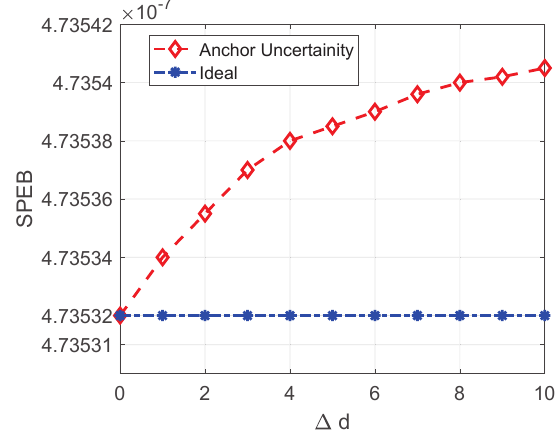
Figure 7. Anchor uncertainty